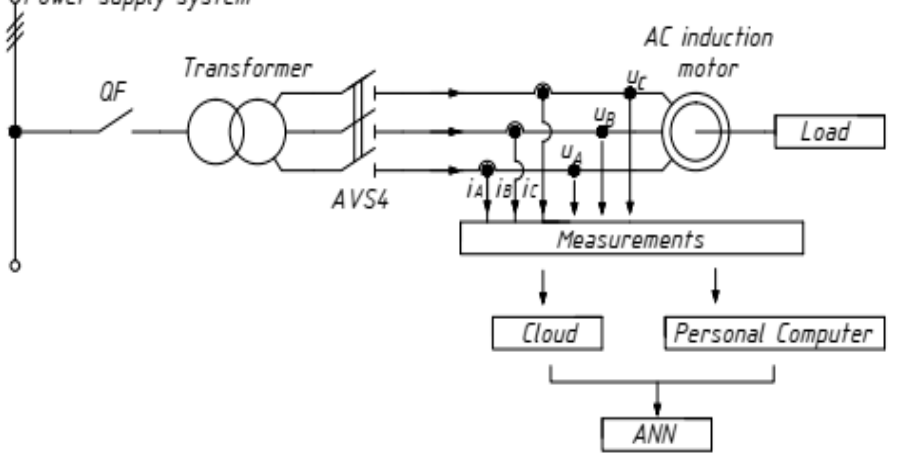
Figure 3. Asynchronous motor AIR132M4, wiring and measurement diagram.